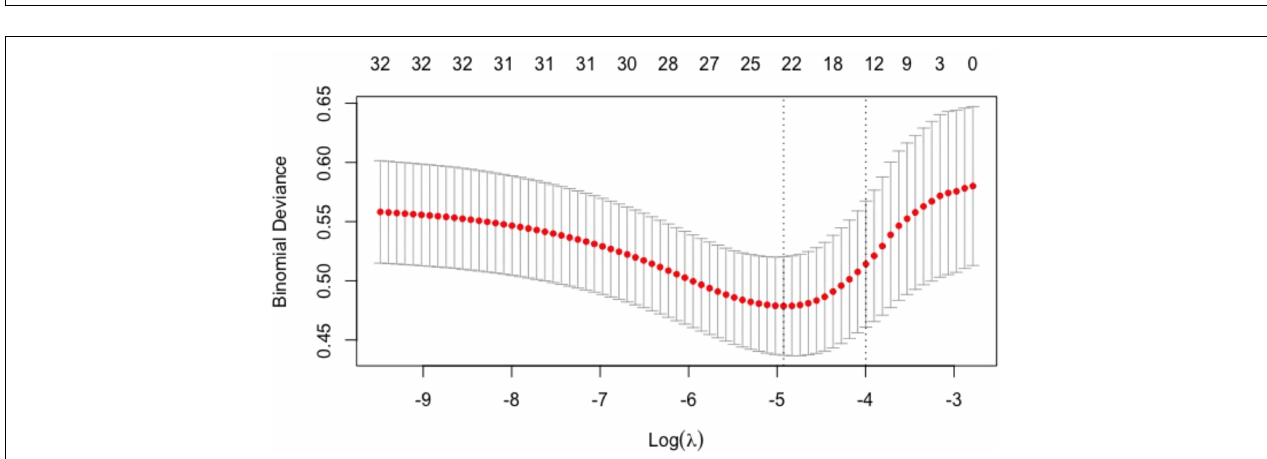
FIGURE 1 | Coefficients of baseline variables in the Lasso regression. Each curve in the figure represented the trajectory of each independent variable coefficient. The ordinate was the value of the coefficient, and the lower abscissa was log( λ ). The upper abscissa was the number of coefficients in the model. According to different λ values, individual coefficients without a coefficient value of 0 were variables included in the model.